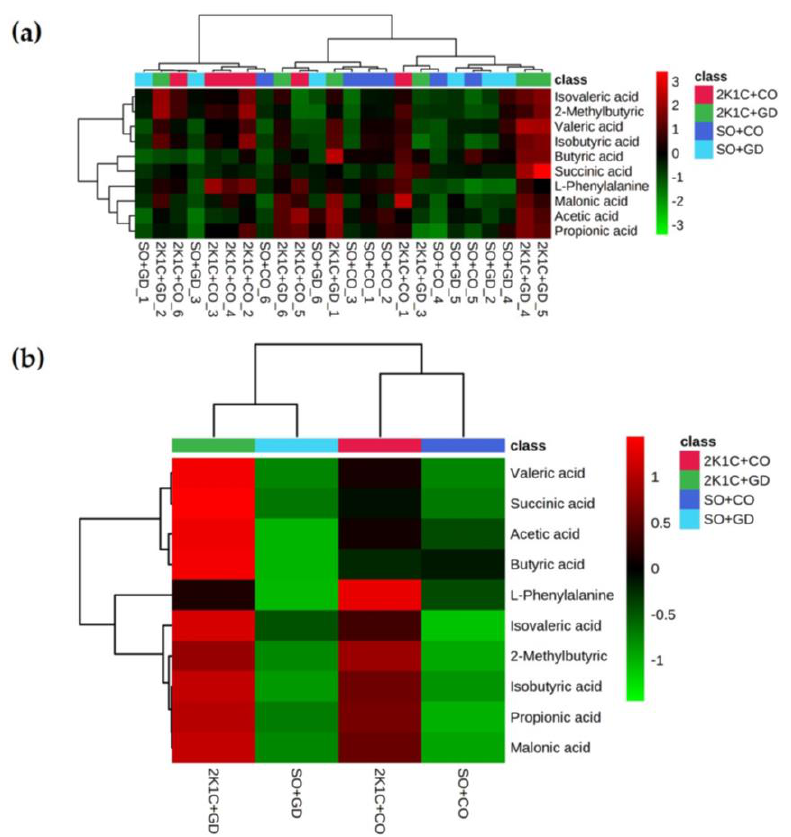
Figure 11. Hierarchical clustering heatmap between the metabolites and rats using Pearson distance measure and the Ward cluster algorithm; ( a ) all 12 rats and ( b ) averages of each rat group. The dendrogram on the left represents dissimilarities between the metabolite clusters, and the dendrogram above the heat map represents similarities between the rats.